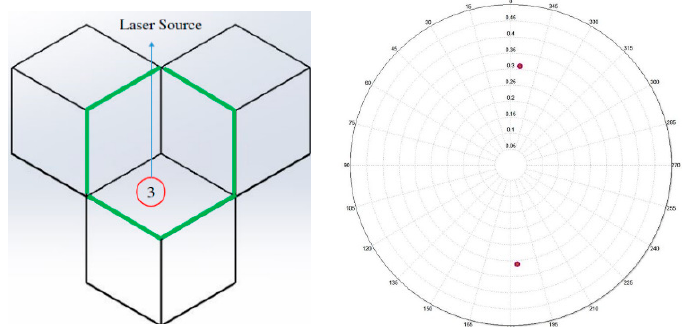
Figure 12. The CCCR #3 reflecting surface in the posterior region is hit by a simulated laser beam ( left ) and the resulting retroreflected light intensity distributions ( right ).